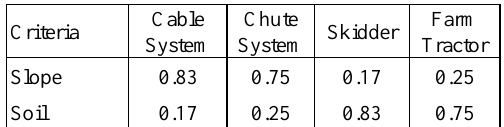
Figure 10. Farm tractor operation